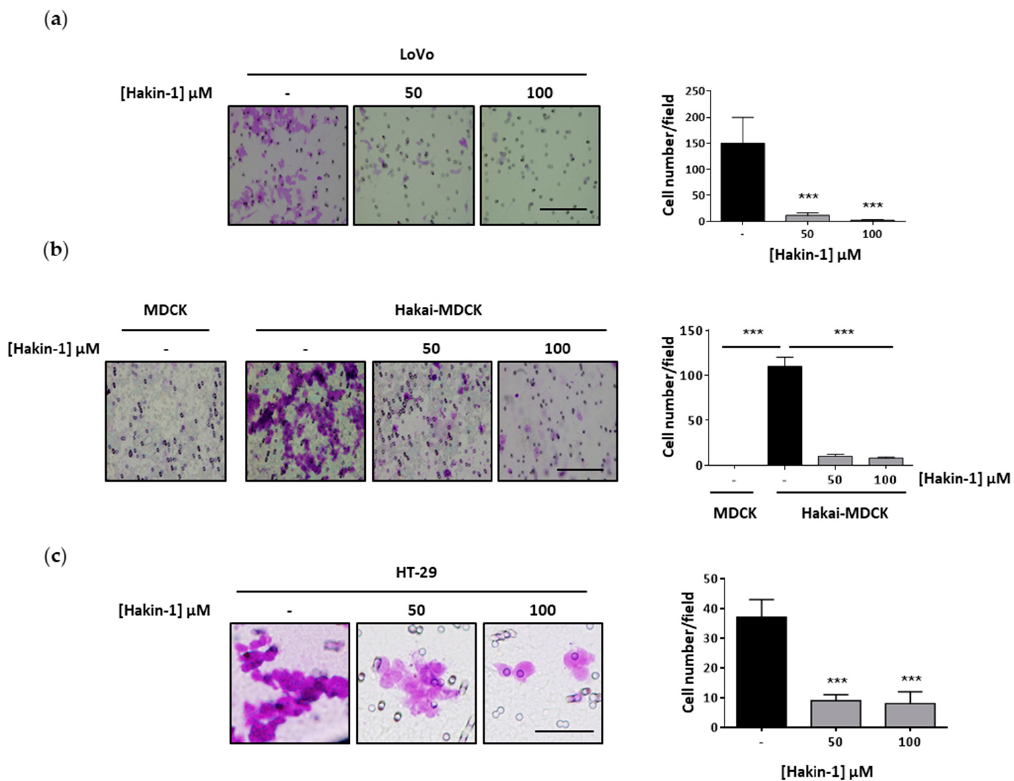
Figure 5. Hakin-1 reduces cell invasion and cell migration of epithelial tumour cells. ( a ) Invasion assay in LoVo cell line was performed as described in Materials and Methods. Cells were treated in the presence of DMSO or Hakin-1 for 48 h before being seeded into an invasion chamber. Representative images were taken using the 20× objective (right panel) and quantification of the photographed invasive cells are shown (left panel). ( b ) Invasion assay was performed as previously indicated by using MDCK and Hakai-MDCK cells. ( c ) Migration assay in HT-29 cells was analysed after treatment with DMSO or Hakin-1 during 48 h. Cells were seeded in a migration chamber as described in Materials and Methods. Representative images taken with 20× objective (right panel) and quantification of migrating cells (left panel) are shown. Results are represented as mean ± SD of triplicates of three independent experiments (*** p < 0.001).